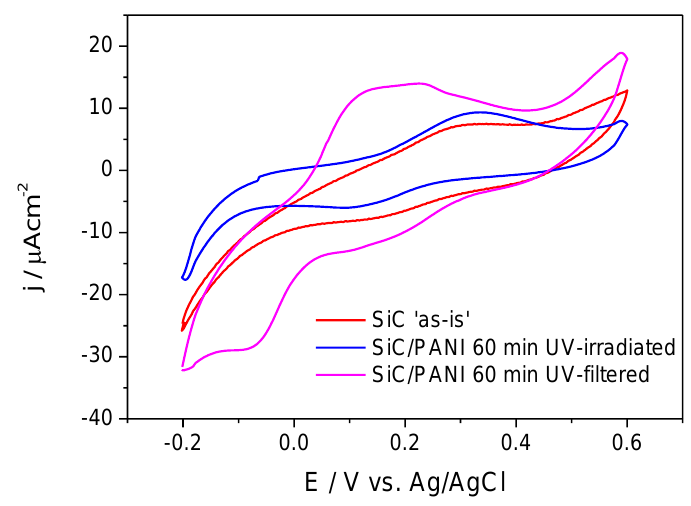
Figure 9. Cyclic voltammograms of the SiC nanoparticles and the synthesized nanocomposites recorded in 0.5 M H 2 SO 4 at a sweep rate of 25 mV/s.